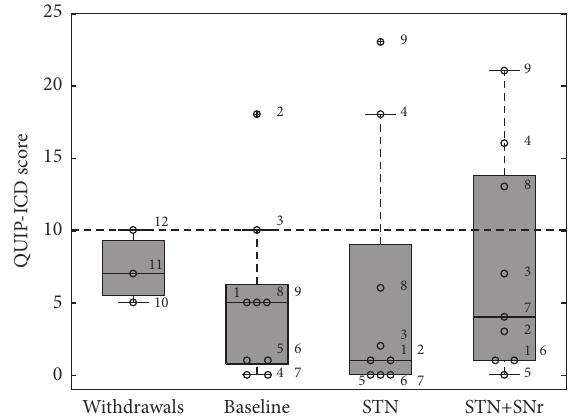
Figure 8: Boxplots of combined QUIP-ICD scores: the box plot depicted on the left represents the baseline values of the three patients who withdrew. The other three box plots represent the values of the 9 PD patients who have completed the study at the three experimental time points: (1) baseline, (2) STN alone, and (3) combined STN+SNr-DBS. The numbered circles represent the singlepatientsaslistedinTable1.ForthecombinedQUIP-ICDscore the cut-off point is ≥ 10.